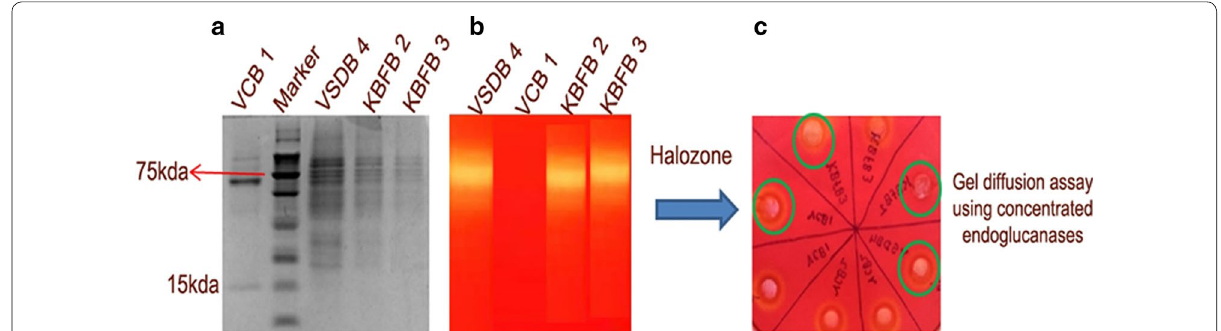
Fig. 6 SDS PAGE and zymogram analysis showing cellulolytic activity. a SDS profile of endoglucanase by the promising thermophilic isolates grown on culture media with CMC; b invitro endoglucanase activity in polyacrylamide gel with CMC; c halo zones showing endoglucanase activity on CMC agarose plates stained with +